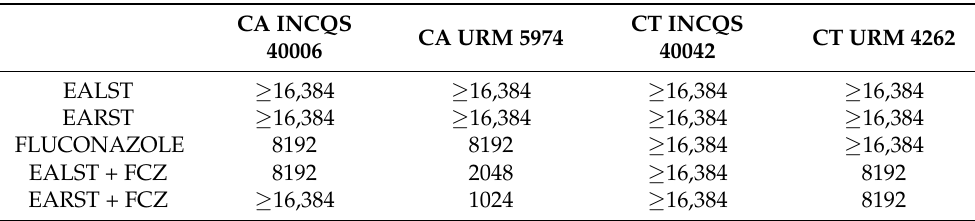
Table 5. Minimum Fungicidal Concentration (MFC) of microorganisms ( µ g/mL) by extracts, flucona- zole, and their